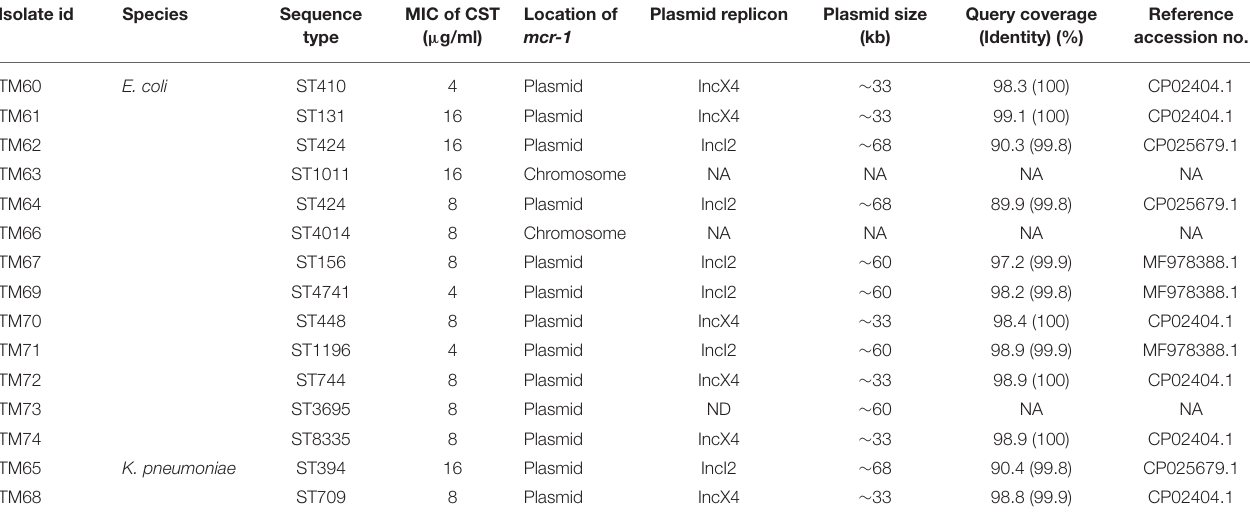
TABLE 2 | Description of mcr-1 gene location, plasmid analysis, and other characteristics of the MCRPEn isolates. Isolate id